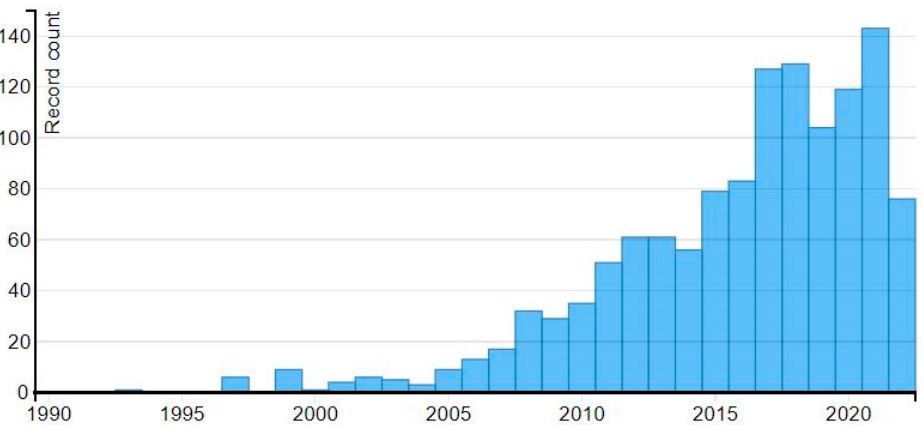
Figure 1. Histogram of publications on urban wind CFD simulations.